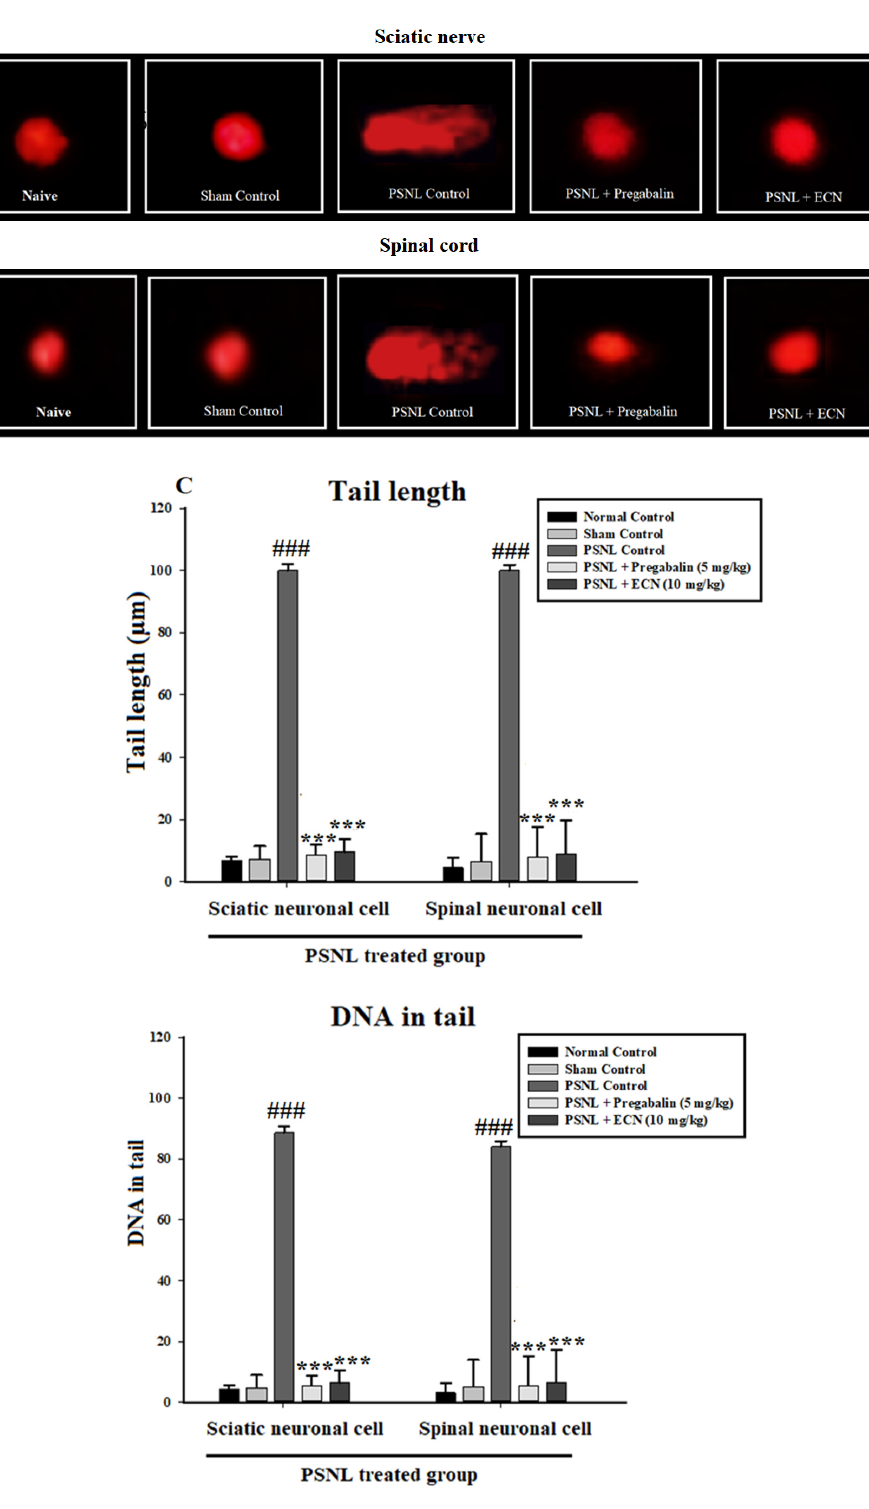
Figure 4. Effect of ECN on DNA damage in the sciatic nerve and spinal cord tissues analysed by comet assay. Fluorescence photomicrographs exhibiting the protective effect of ECN against PSNL induced DNA damage in ( A ) sciatic nerve and ( B ) spinal cord. ( C ) DNA content is estimated by tail length and % DNA in the tail in the PSNL experiment. The data is presented as the mean (n = 5) ± S.D. Different letters meant statistically significant differences: (***) p < 0.001 indicate significant differences from the PSNL control group. (###) indicate significant differences from the normal control group. *** p < 0.001 (one-way ANOVA followed by Bonferroni